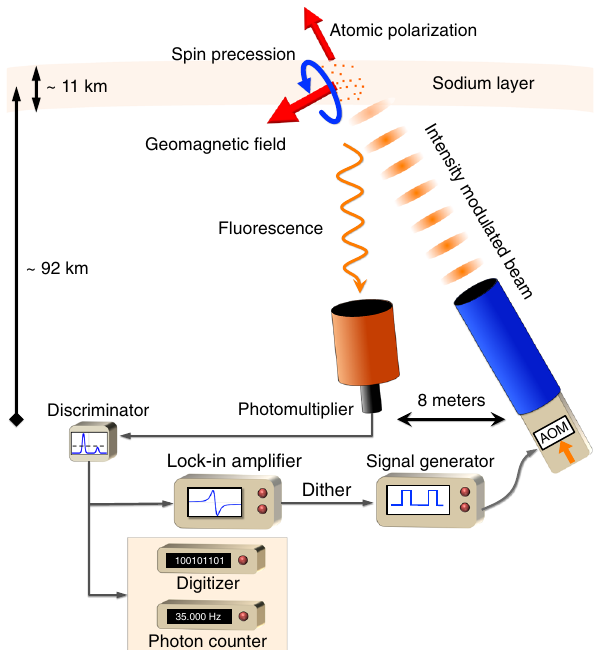
Fig. 1 Experimental arrangement. A laser projector sends an intensity- modulated beam to the mesosphere where it polarizes sodium